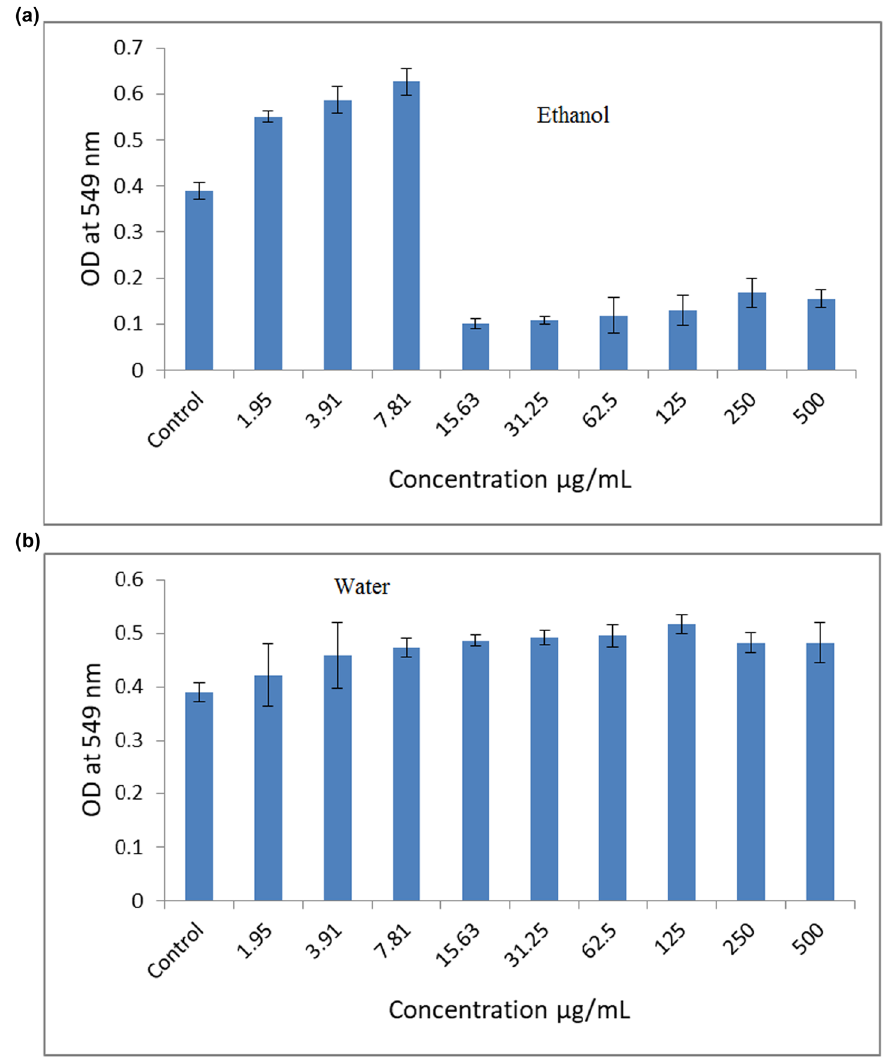
Figure 1: ( a ) E ff ect of di ff erent doses of ethanol plant extract on the proliferation of normal human cultured melanocytes as measured by MTT 72 h following exposure. ( b ) E ff ect of di ff erent doses of water plant extract on the proliferation of normal human cultured melanocytes as measured by MTT 72 h following exposure; OD: optical